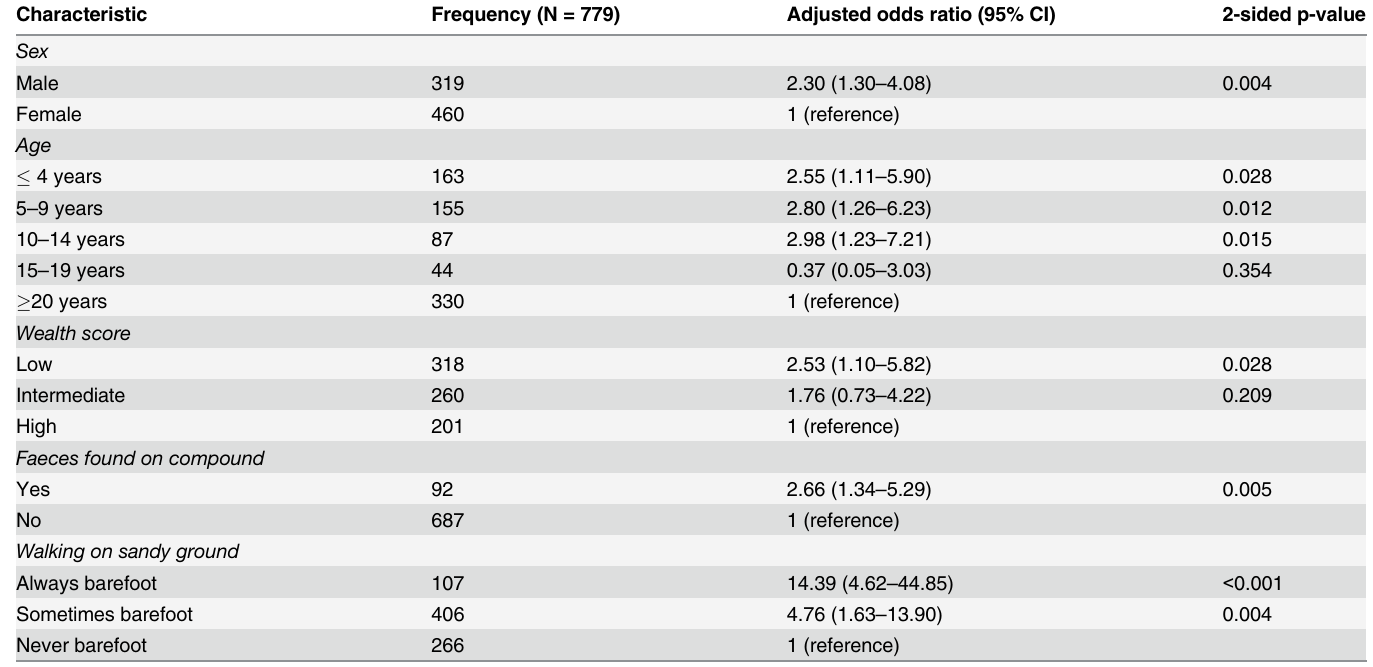
Table 4. Multivariable regression